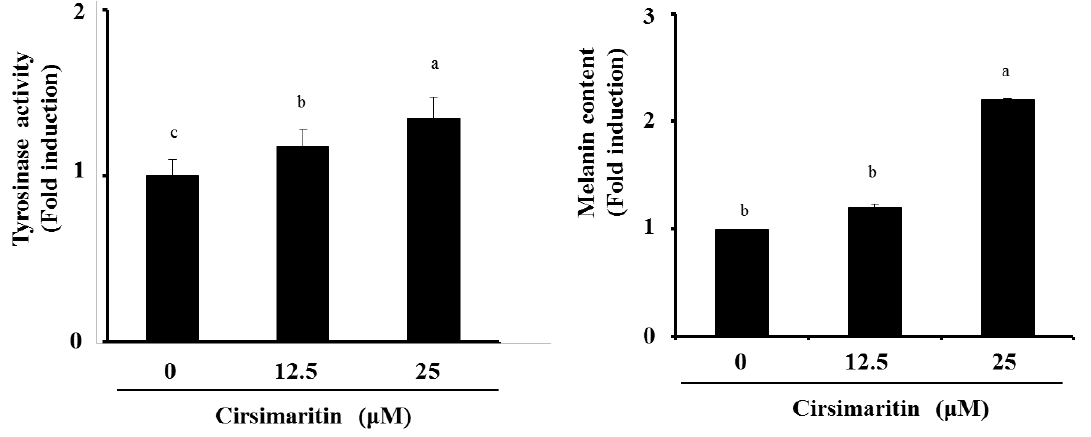
Figure 6. Effects of cirsimaritin on melanin content in human melanocytes. Normal human epidermal melanocytes were treated with cirsimaritin at various concentrations for 48